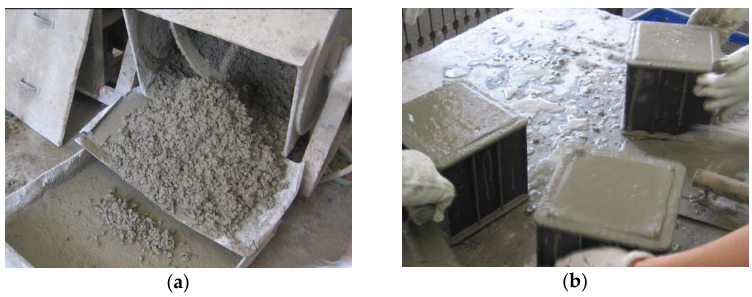
Figure 2. Photographs for GB concrete mixing and casting: ( a ) anchor type of concrete mixer; ( b ) elimination of entrapped air from specimens using vibration table. Table 1. Chinese Standard Concrete mix proportions.